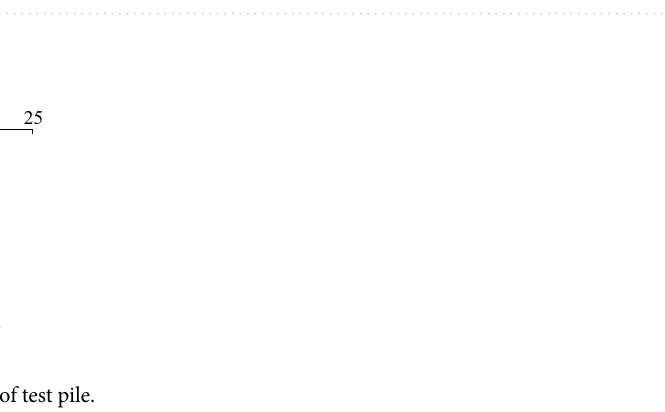
Figure 5. Model pile and soil distribution: ( a ) soil distribution and position of pile in finite element analysis; ( b ) model.